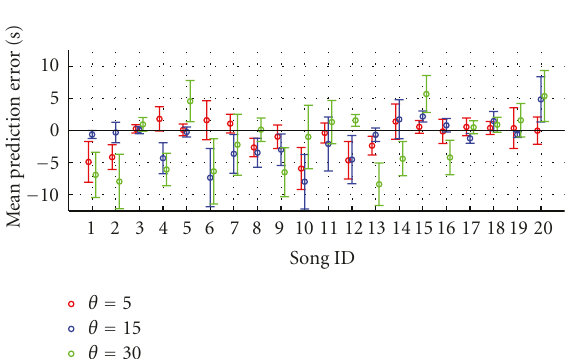
Figure 8: Window width θ versus prediction